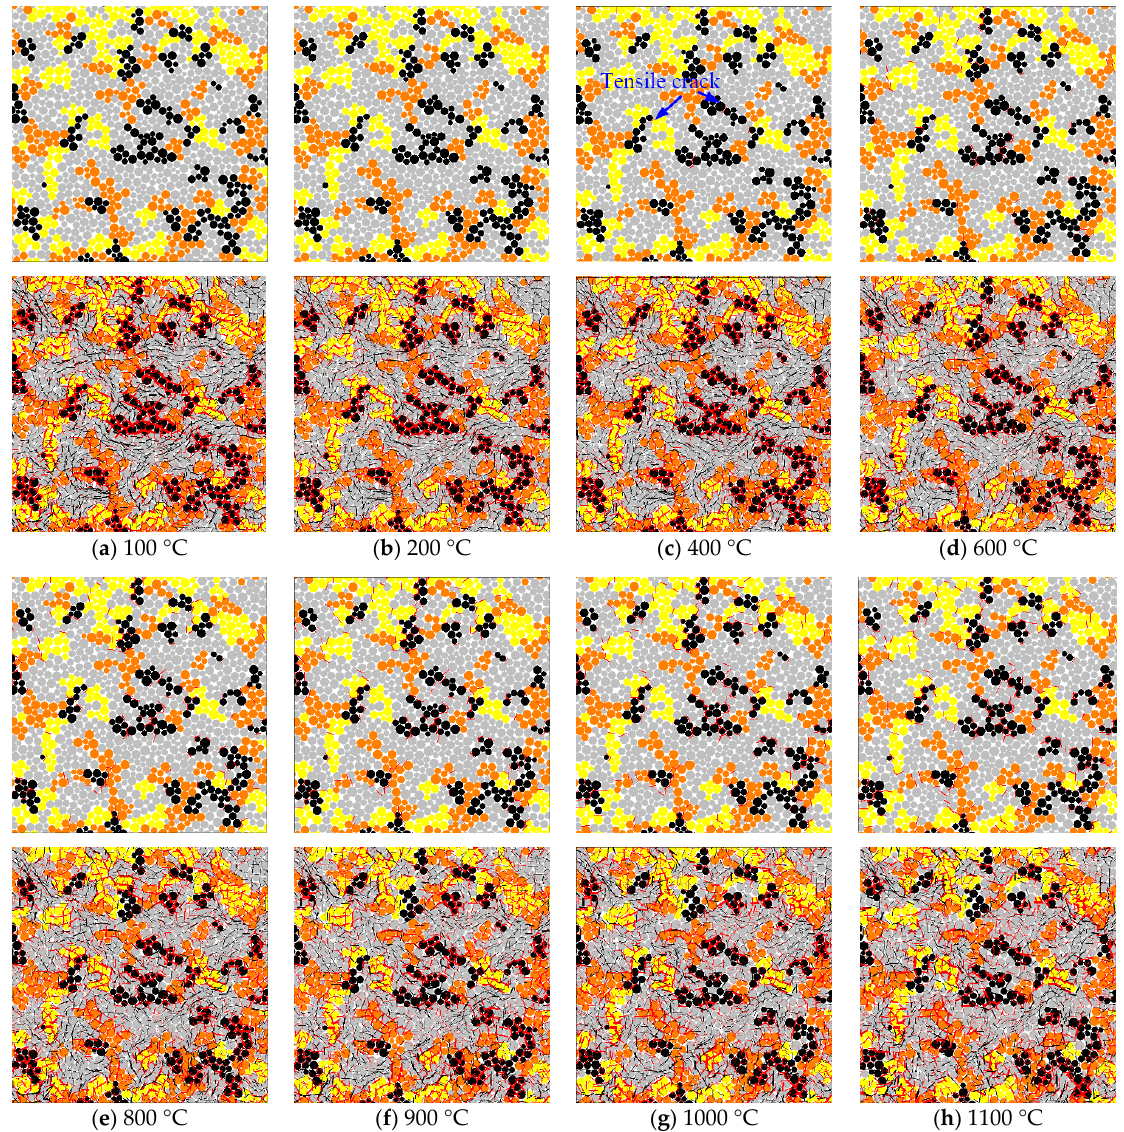
Figure 4. Distribution of micro-cracks and parallel bond forces at different temperatures: ( a ) 100 °C;